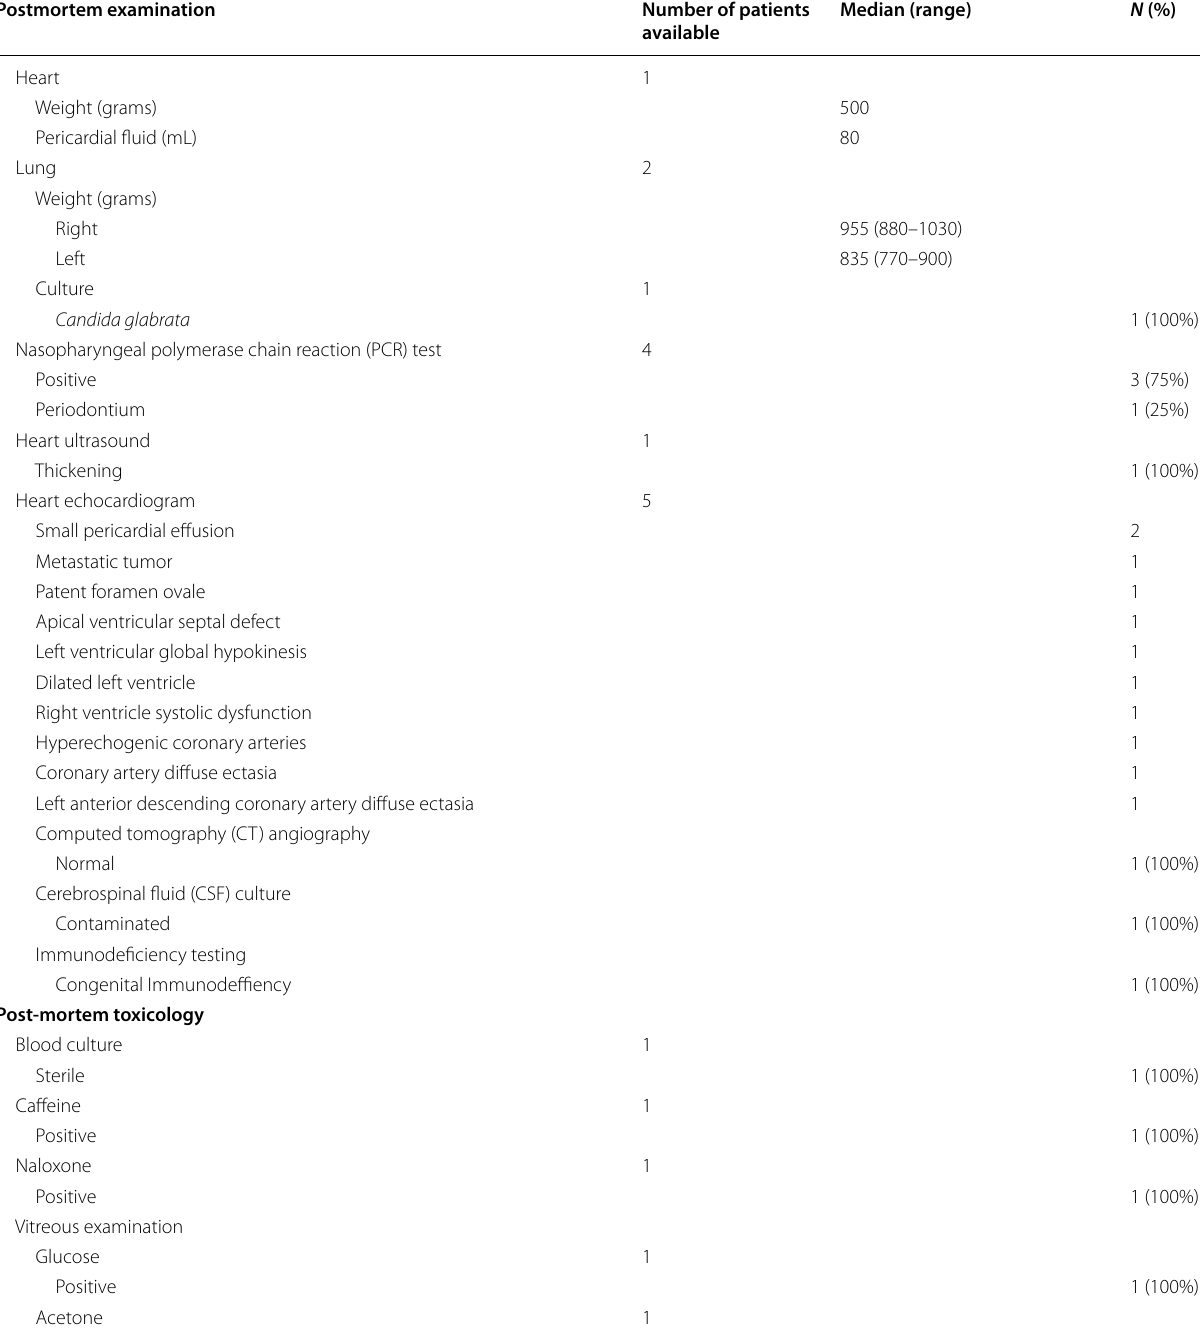
Table 4 Postmortem examination Postmortem examination Number of patients